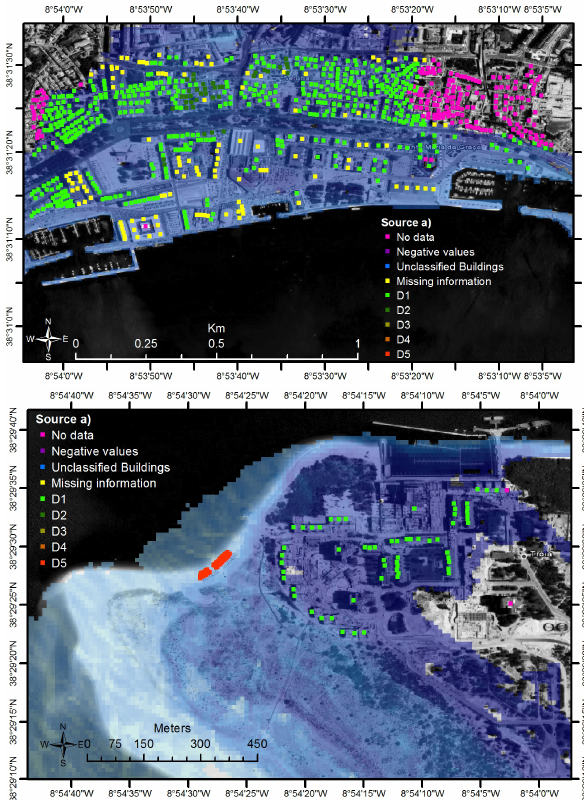
Fig. 6. Damage calculated by the Damasche tool for the Set´ubal and Tr´oia